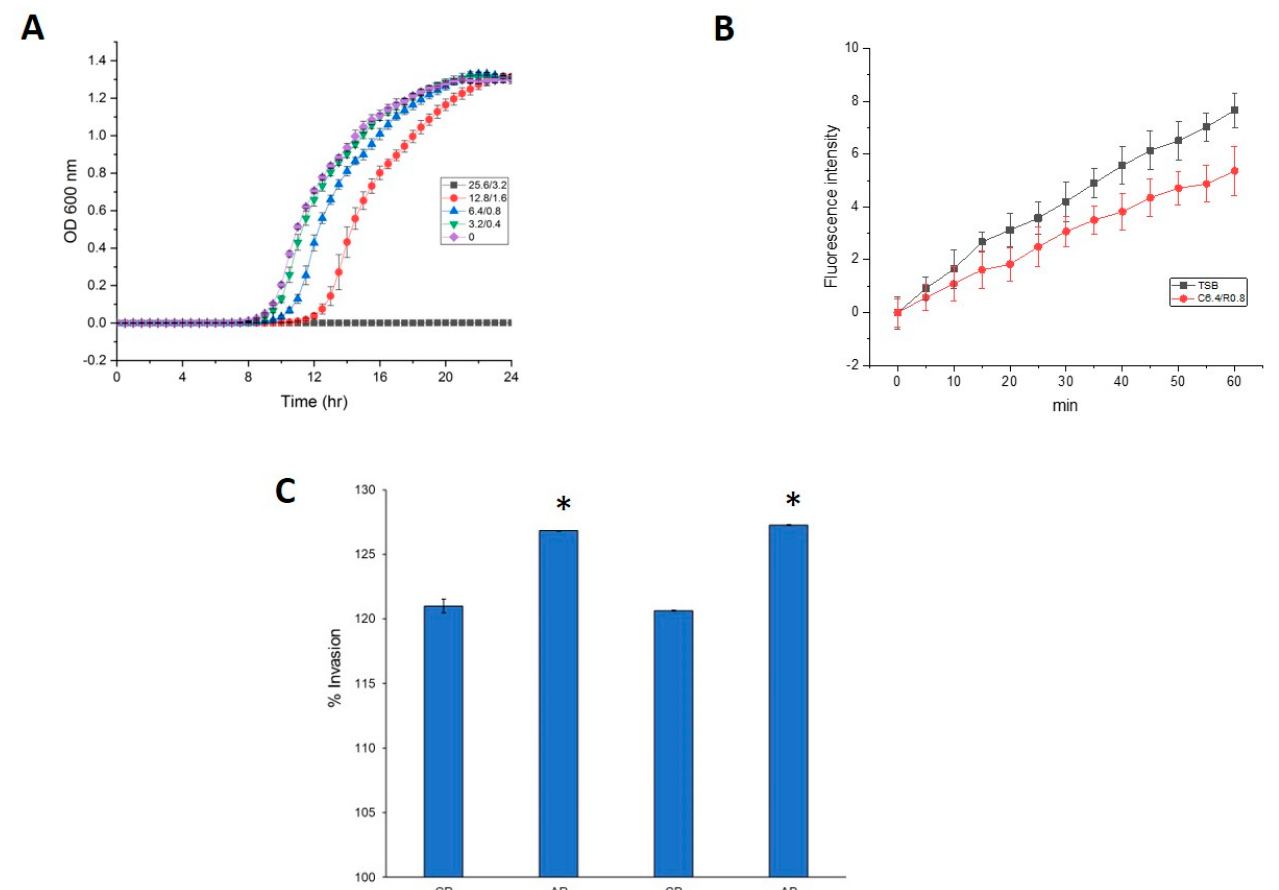
Figure 5. ( A ) Growth curve of strain PAO1 containing various mixtures of clindamycin and rifampicin (3.2 and 0.4, 6.4 and 0.8, 12.8 and 1.6 and 25.6 and 3.2 µg/mL, respectively) in TSB. Experiments were performed in triplicate to calculate the mean and standard deviation. ( B ) Accumulation of ethidium bromide in strain PAO1 containing a mixture of clindamycin (6.4 µg/mL) and rifampicin (0.8 µg/mL) in TSB. The natural fluorescence of the cells was subtracted and the fluorescence intensity was expressed in relative fluorescence units (RFU). All experiments were performed in triplicate. Error bars indicate standard deviation from the mean. ( C ) Invasion of P. aeruginosa PAO1 in the human cervical epithelial adenocarcinoma HeLa (ATCC CCL-2) cells. The % of invasion was calculated by dividing the number of invaded cells by the initial number of inoculated bacteria. The assays were performed in quadruplicate and data are represented as mean ± SD. Data were subjected to a one-way analysis of variance followed by a Tukey’s post hoc test. Differences were considered statistically significant (*) when p < 0.05. CP: planktonic cells grown with control catheter; CB: biofilm cells grown with control catheters; AP: planktonic cells grown with antibiotic-impregnated catheter; AB: biofilm cells grown with antibiotic-impregnated catheter.